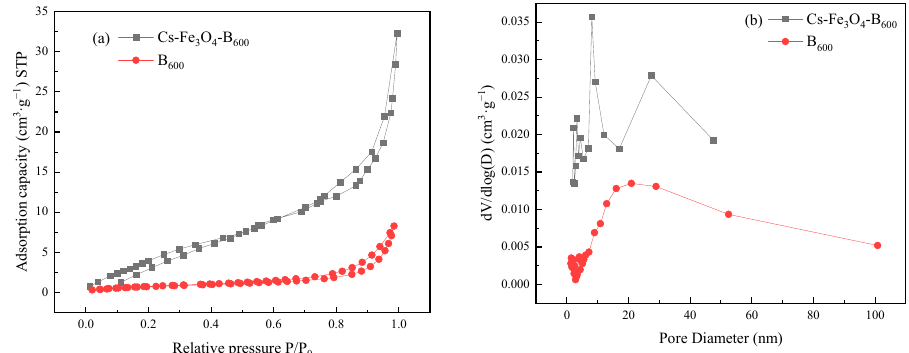
Figure 2. ( a ) N 2 adsorption–desorption isotherms and ( b ) pore size distribution (BJH) of B 600 and Cs- Fe 3 O 4 -B 600 . Note: STP means standard temperature and